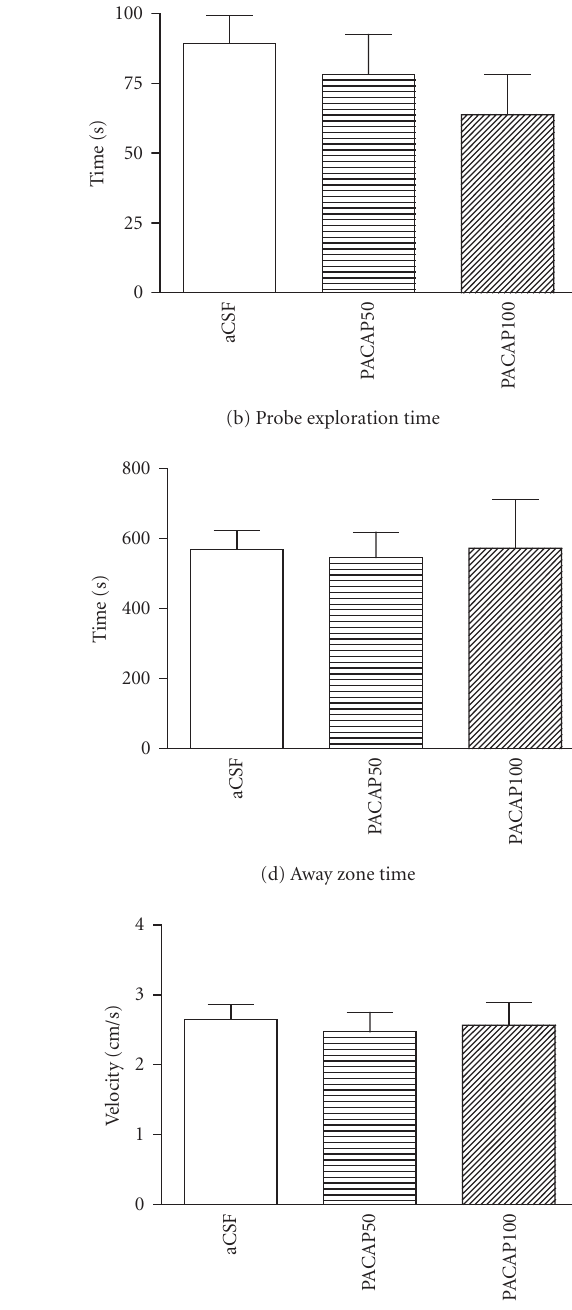
CeA (Koves et al. [17]; Piggins et al. [19]; Hannibal